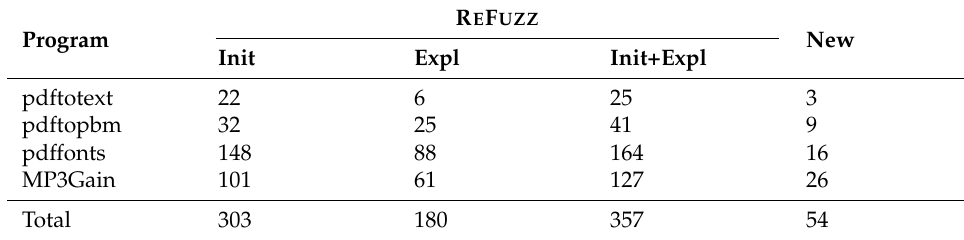
Table 5. Number of unique crashes (40 + 40).